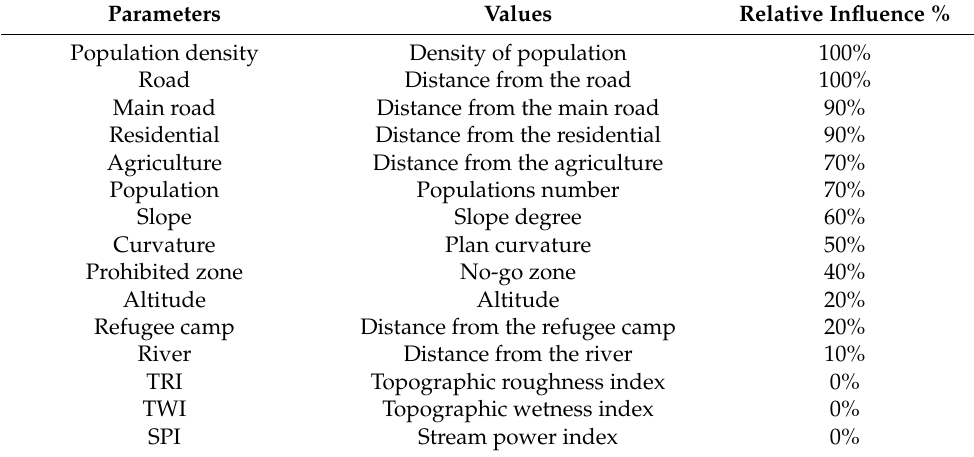
Table 1. Relative influence (%) of the effective